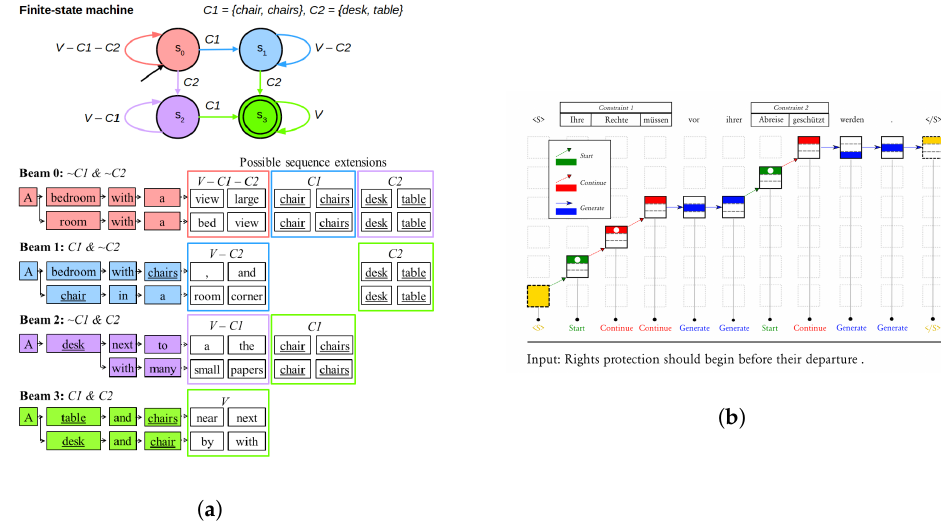
Figure 2. Versions of the beam search that incorporate lexical constraints. ( a ) Constrained beam search [161]. ( b ) Grid beam search